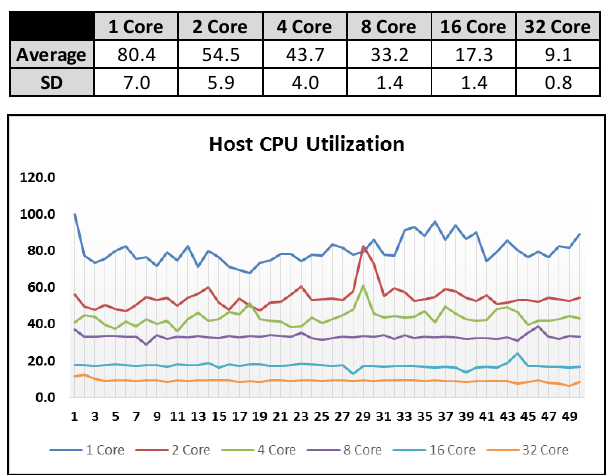
Table 4: AMD Legacy Host CPU %